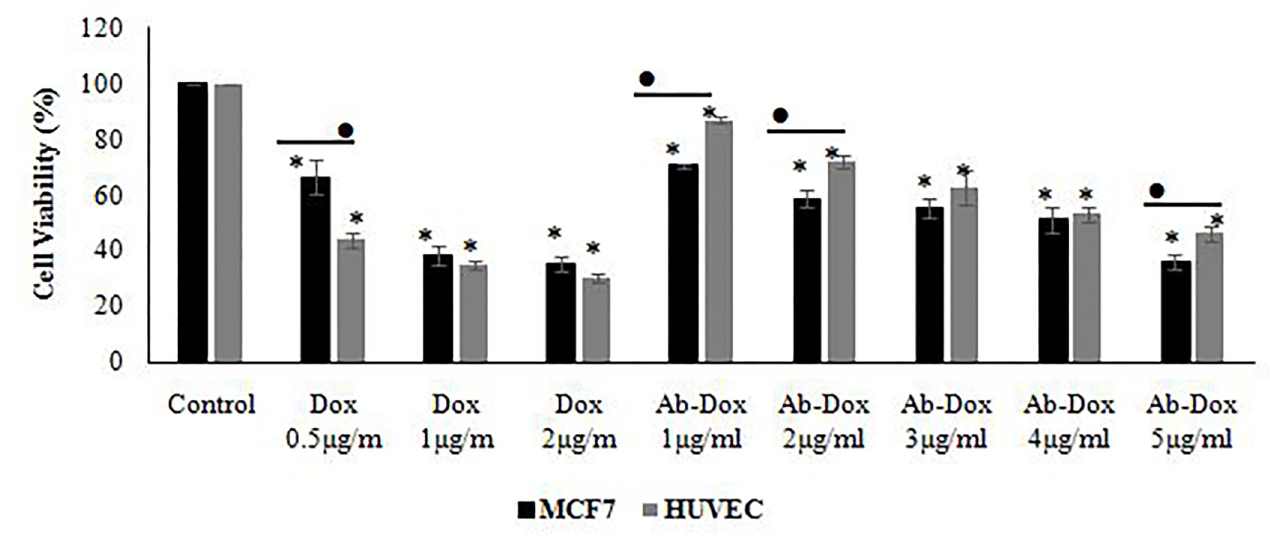
Fig 9. Viability of the MCF7 and HUVEC cell lines after treatment with doxorubicin and antibody conjugated to doxorubicin using the MTT test. The significant differences in the treatment compared to control group and MCF7 compared to HUVEC were shown by using asterisks ( � ) and the bullet (•), respectively (p <